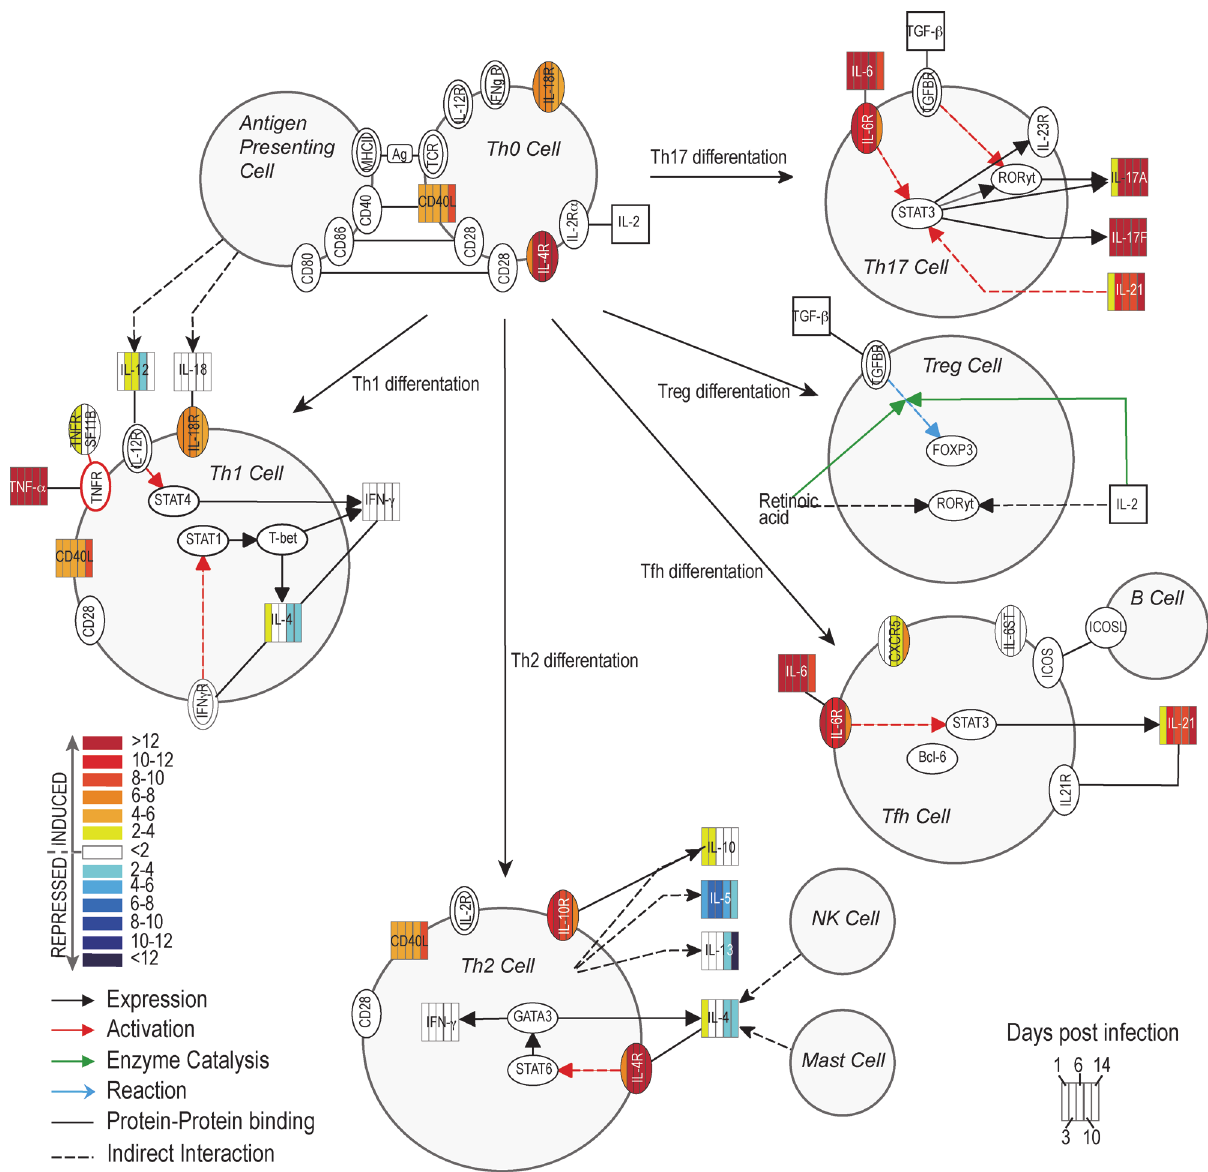
Fig 4. S . aureus skin infection causes changes in transcripts encoding molecules involved in Th lymphocyte differentiation. The networks/ functional analyses were generated through the use of QIAGEN ’ s Ingenuity Pathway Analysis (IPA, QIAGEN Redwood City, www.qiagen.com/ingenuity). The heat map representing changes in transcript levels of molecules on day 1, 3, 6, 10 and 14 during 14-day course of infection, was created using Adobe Illustrator CS5.1 software. Empty symbols indicate molecules not evaluated by the RT² Profiler PCR